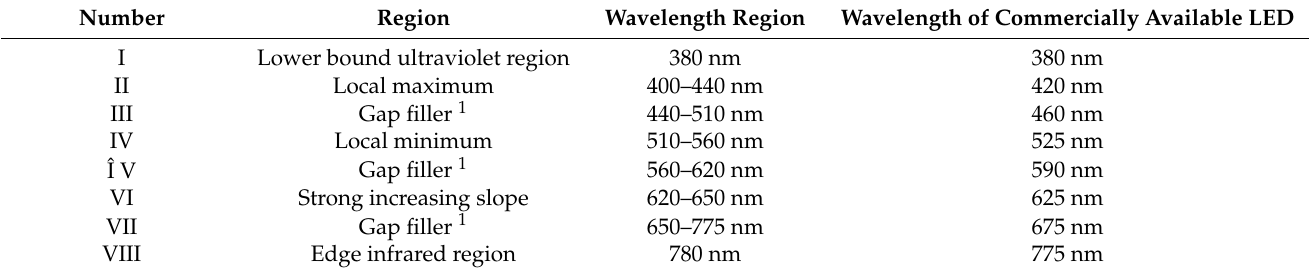
Table 1. Supporting points chosen in transmission spectra for color determination of red and white wine based on interpolation methods. Supporting points were chosen based on transmission spectra of red wine (Figure